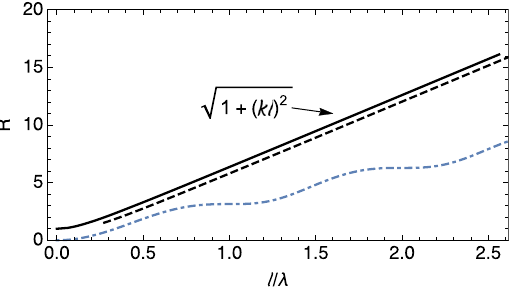
FIG. 2. Transformer ratio. Solid black line is given by Eq. (15). The dot dashed and dashed curves correspond to the cases (a) and (b) described in the text. As expected, the dashed curve lies only slightly below the theoretical maximum.